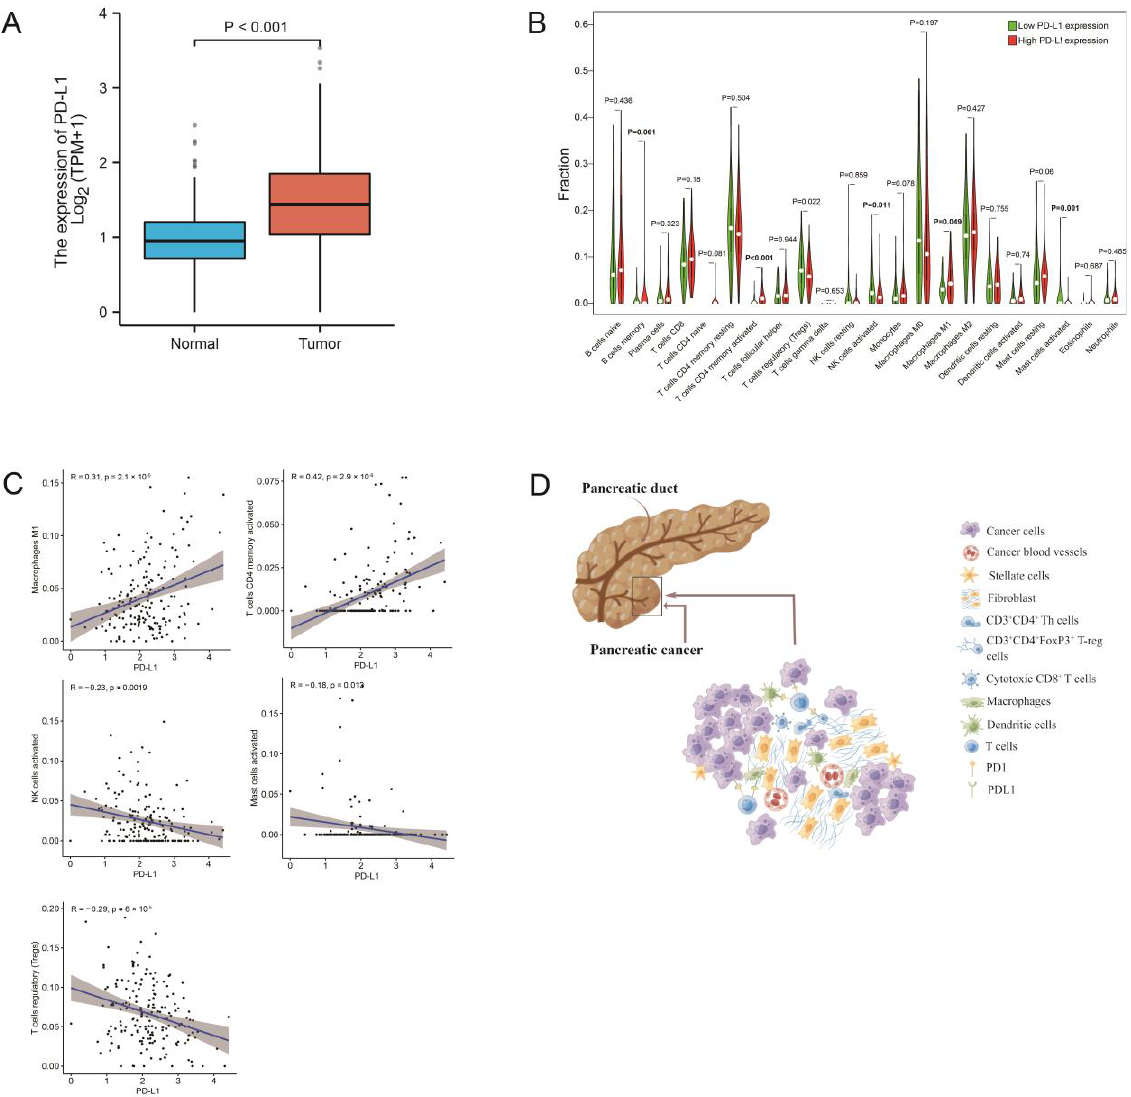
Figure 6. The correlation of TIC proportions and PD-L1 expression in pancreatic cancers. ( A ) Differ- entiated expression of PD-L1 in the normal and tumor samples. Analyses were conducted across all normal and tumor samples by the Wilcoxon rank sum test. ( B ) Violin plot showed the ratio differ- entiation of 22 types of immune cells between PDAC samples with low or high PD-L1 expression. ( C ) The scatter plot shows the correlation of 5 kinds of TIC proportions with the PD-L1 expression in PDAC ( p < 0.01). The Pearson coefficient was used for the correlation test. ( D ) Tumor cells affect the composition of the immune microenvironment through PD-1/PD-L1 blockade. Figure 6D was created by Figdraw.